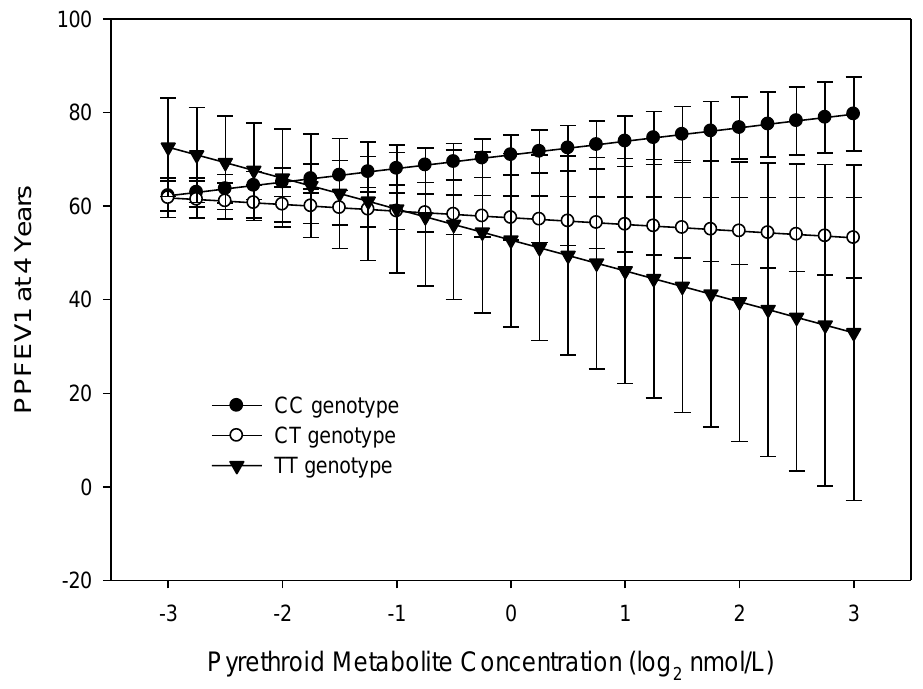
Figure 6. Child’s predicted percent FEV1 at age 4 years related to maternal PON1 − 108 genotype and maternal pyrethroid (3-Phenoxybenzoic acid, 3PBA) metabolite concentration ( n = 102).